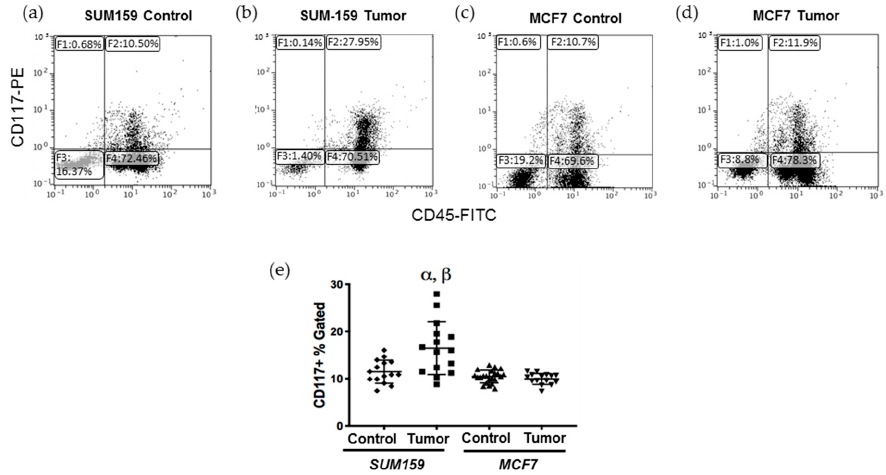
Figure 1. Mice bearing triple negative SUM159 tumors demonstrate an enhanced CD117 + cell population in the bone marrow. Triple-negative SUM159 or luminal A MCF7 human breast cancer cells were injected into the mammary fat pad of female nude mice, and primary breast tumors were allowed to develop up to a mean tumor size of 1500 mm 3 . Animals were euthanized at the endpoint, and bone marrow (BM) was immediately extracted and stained with primary anti-CD117-PE and anti-CD45-FITC antibodies and analyzed by flow cytometry as described in Supplemental Figure S2. Cells (10,000 / sample) were analyzed to assess di ff erences in CD117 + cells within the total BM population. ( a – d ) Representative flow cytometry histograms of the CD117 + BMDC population (gate F2) in ( a ) age-matched tumor-naïve mice (controls for SUM159); ( b ) SUM159 tumor-bearing mice; ( c ) age-matched tumor-naïve mice (controls for MCF7) and ( d ) MCF7 tumor-bearing mice. ( e ) Compiled flow cytometry data for all groups ( n = 15 mice / group). Data are presented as the mean ± SEM. α = significantly di ff erent from respective age-matched controls. β = significantly di ff erent from MCF7 tumor-bearing mice ( p <